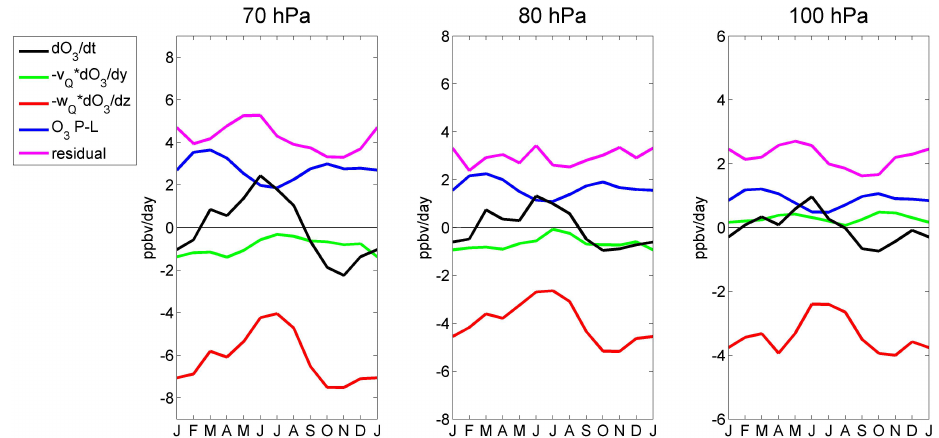
Fig. 6. Mean seasonal cycle for the period 2005–2010 of the terms in the continuity equation for ozone concentration (Eq. 5) averaged over 18 ◦ N–S at the indicated levels (ppbvday − 1 ).